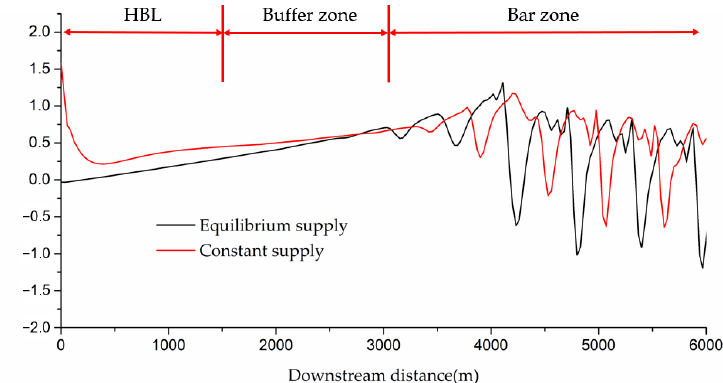
Figure 3. 1D bed profiles of Case 1 along the right bank 6000 m upstream after 25 hydrographs.